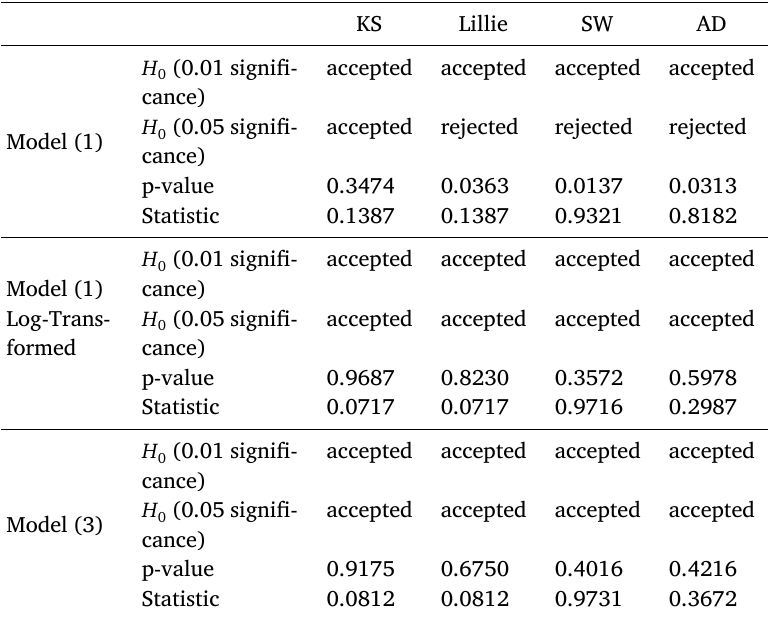
for the normality of the